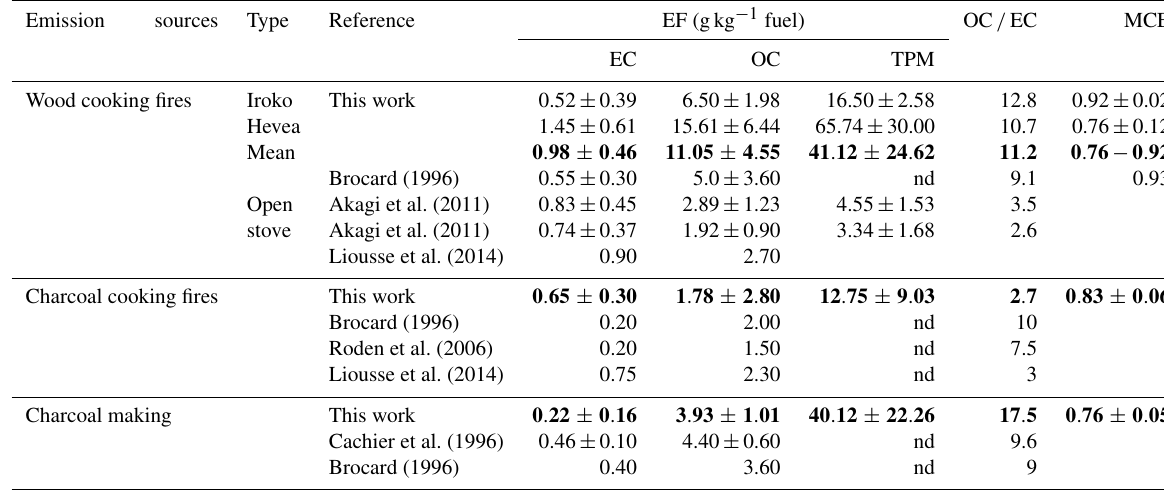
Wood cooking fires